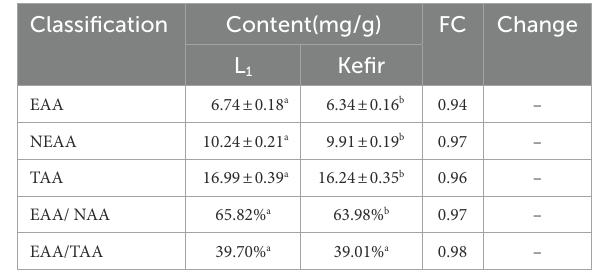
TABLE 4 The contents of free acid in Kefir and L 1 fermented